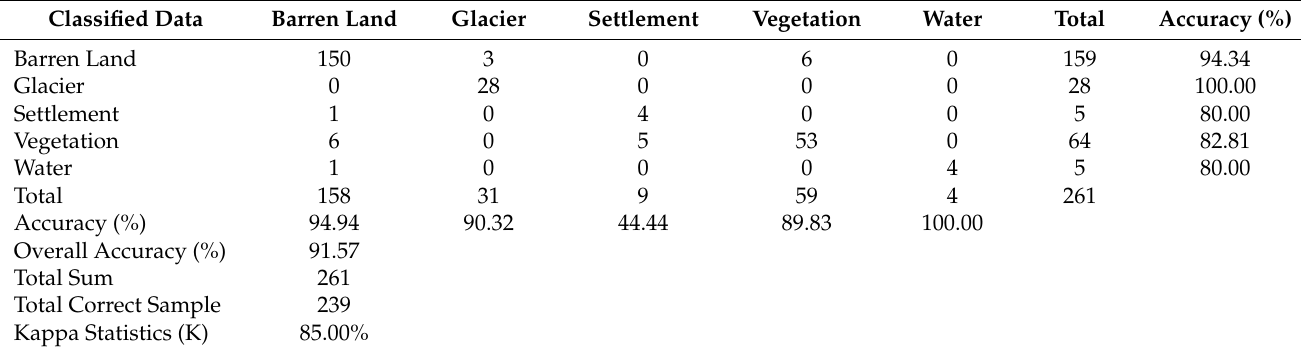
Table 2. The table showing the surface feature accuracy